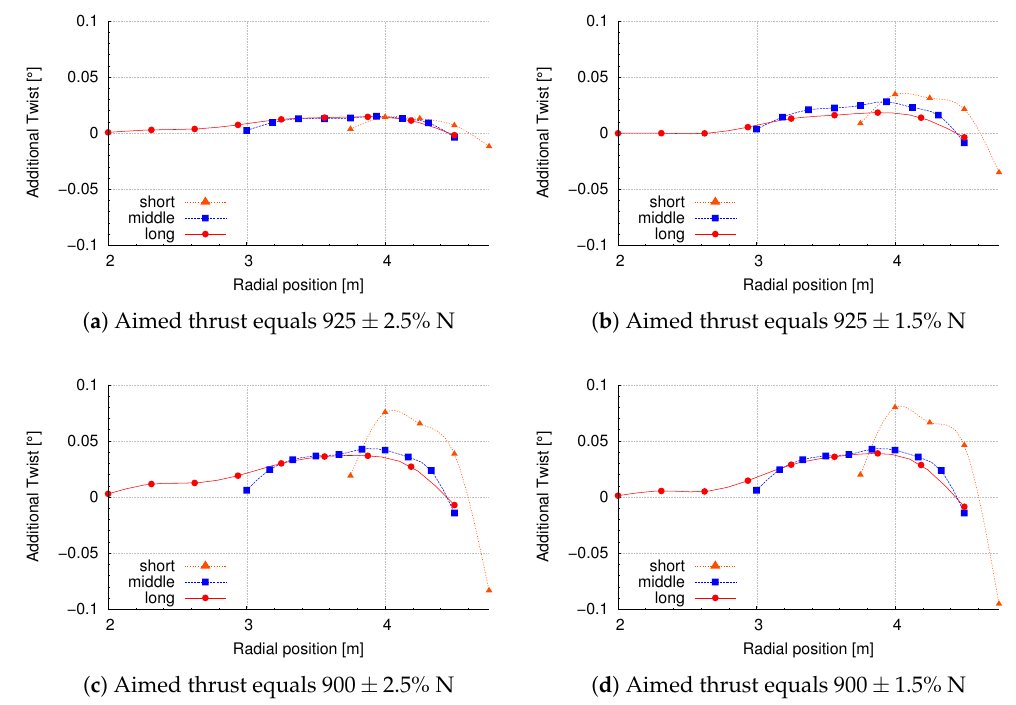
Figure 7. Development of the normalized thrust force over the optimization steps for design parameters within varying deformable parts of the blade. Long: r 1 = 2 m–4.5 m radial position, middle: r 2 = 3 m–4.5 m radial position and short: r 3 = 3.75 m–4.75 m radial position.